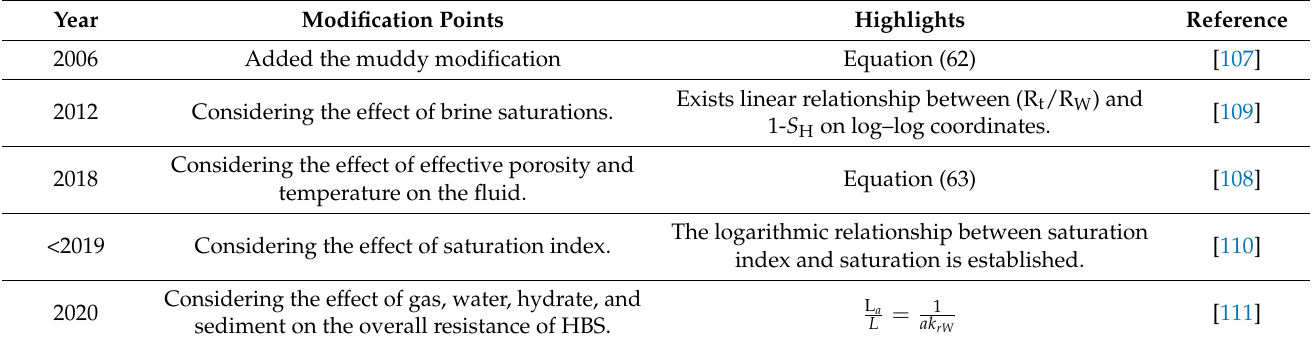
Table 6. The advances in electrical resistivity on hydrate saturation/permeability.